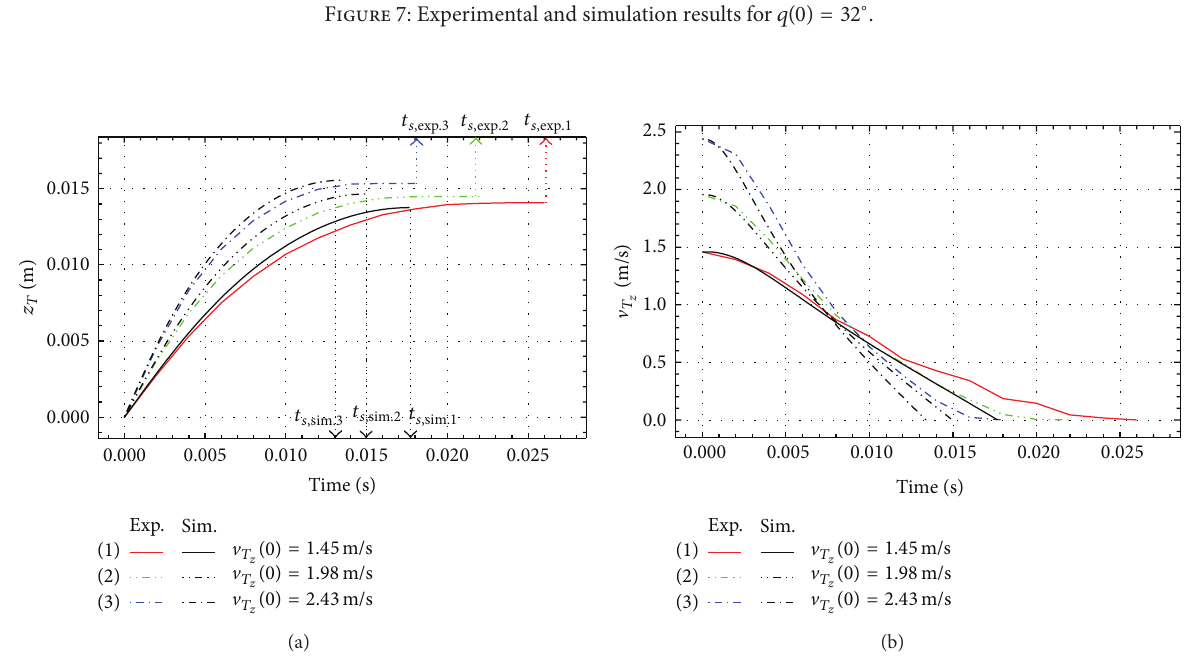
Figure 7: Experimental and simulation results for 𝑞(0) = 32 ∘ .